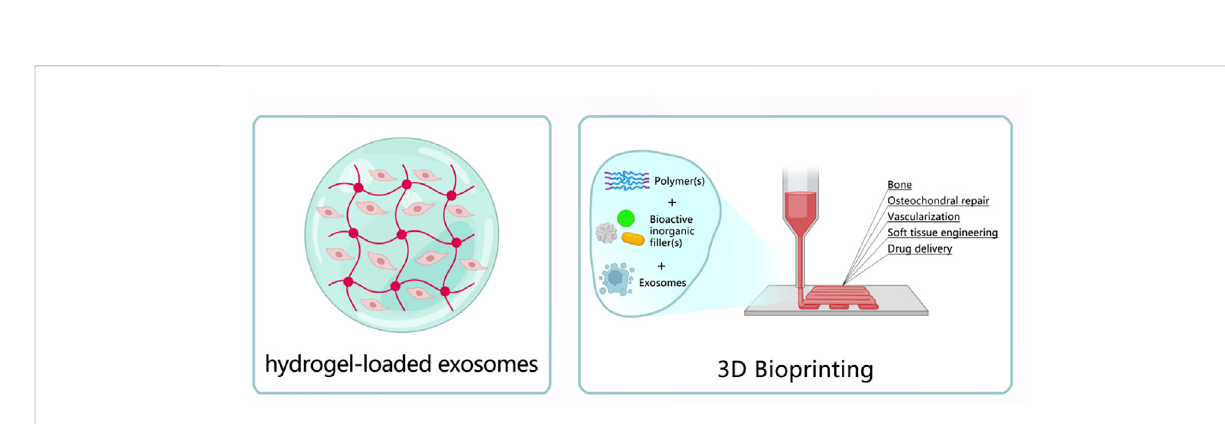
FIGURE 2 Exosomes loaded hydrogels. (1) Hydrogels carried exosomes. (2) 3D